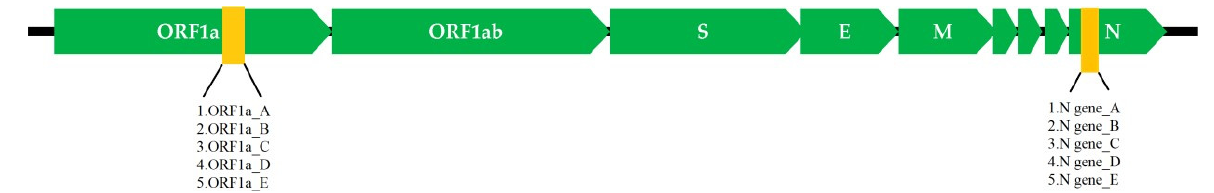
Figure 1. Illustration of SARS-CoV-2 genes. The diagram shows all genes presented in the virus genome. The ORF1a and N genes were targeted by the developed RT-LAMP assay, with five primers against each gene (A, B, C, D, and E) designed for that purpose.